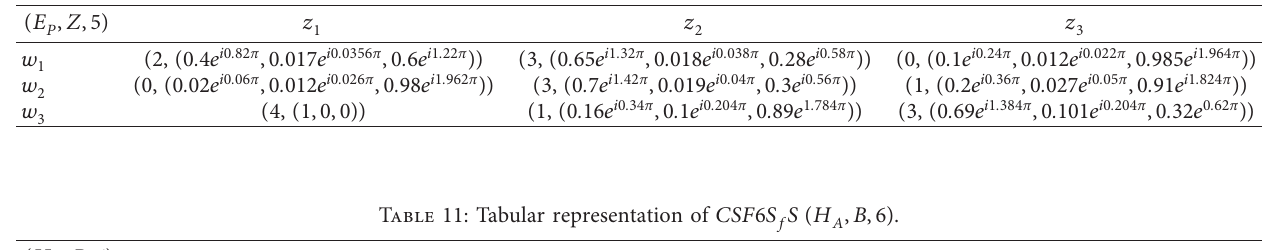
Table 10: Tabular representation of the CSF 5 S